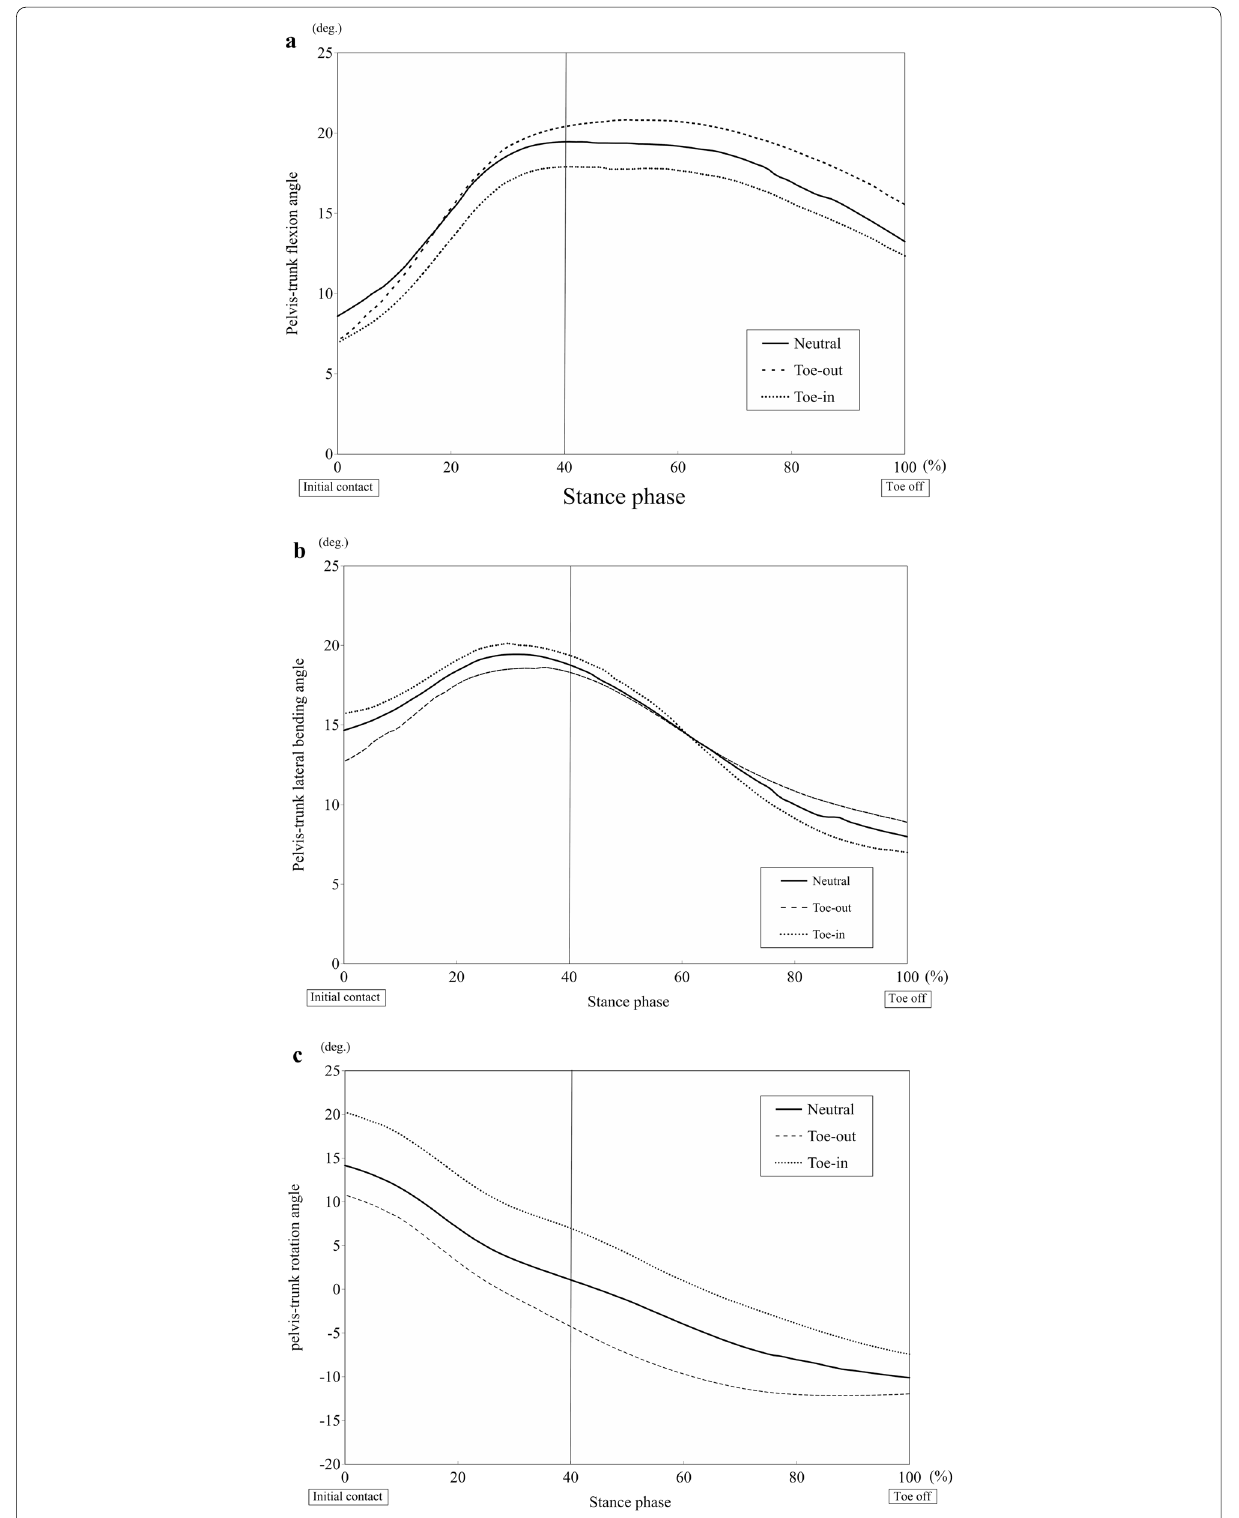
Fig. 3 Waveforms showing the average pelvis-trunk flexion angle ( a ), pelvis-trunk lateral bending angle ( b ), and pelvis-trunk rotation angle ( c ) during the stance phase of the cutting